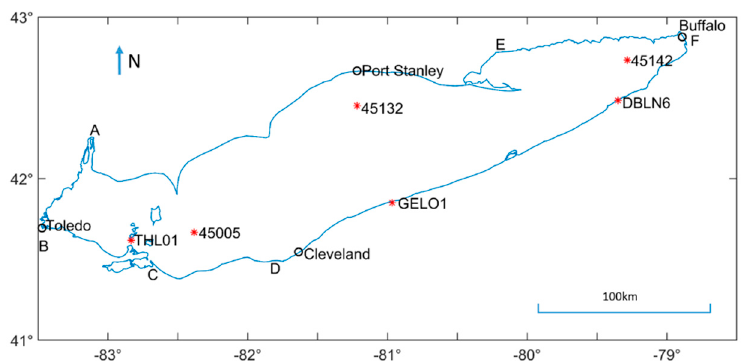
Figure 2. Lake Erie bathymetric plan view (generated from GLERL data); Meteorological stations (red stars); Water level stations (black circles): Toledo, Port Stanley, Buffalo, and Cleveland; A~F represent Detroit, Maumee, Sandusky, Cuyahoga, Grand, and Niagara Rivers.